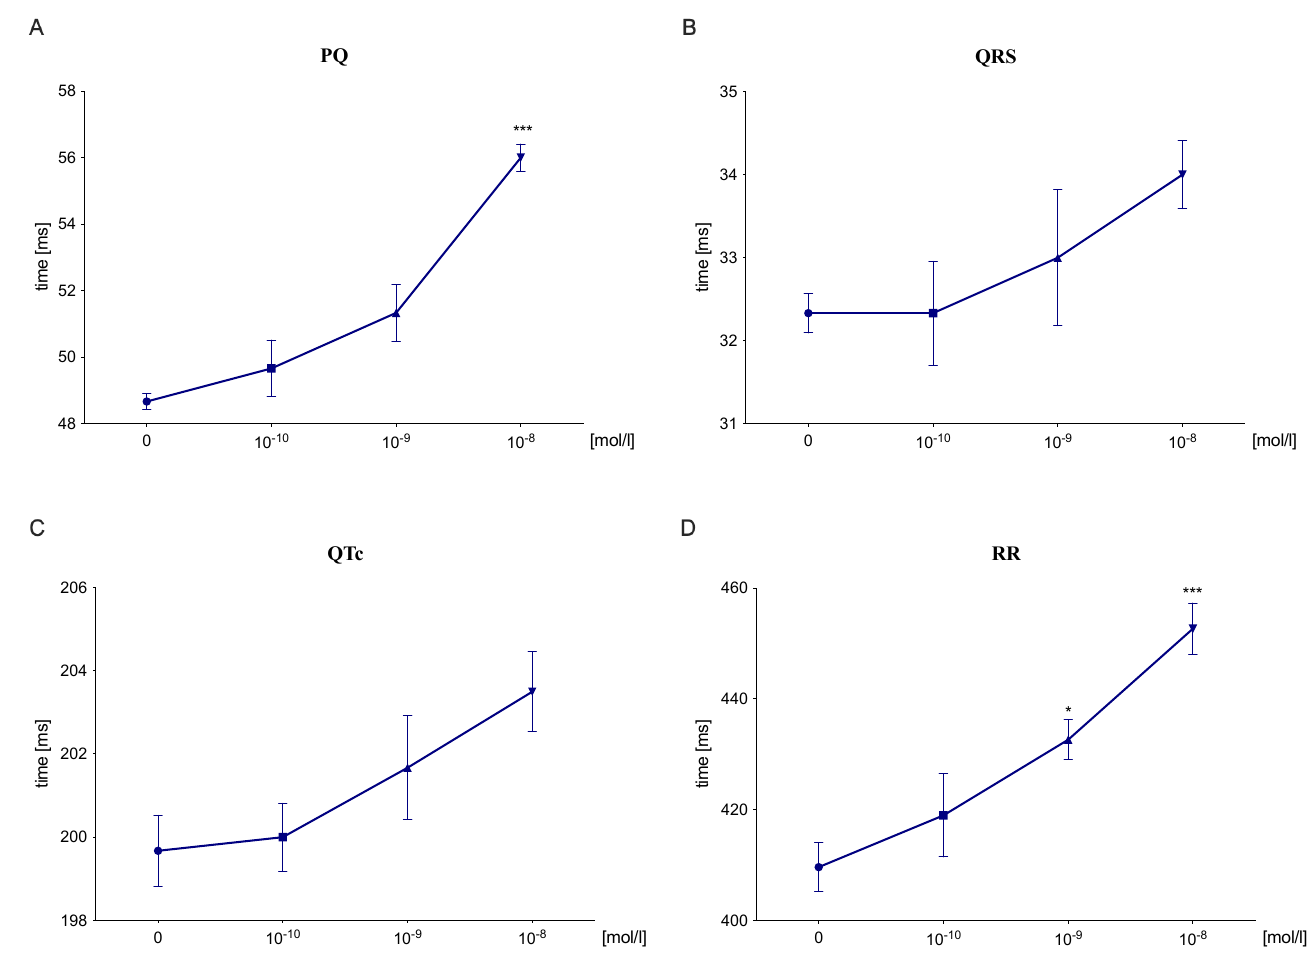
Figure 1. The effect of S-75 on the ECG components of the isolated rat heart. After stabilization period, the tested compound was administered directly to the nutrient fluid, in which heart was submerged, every 15 min at increasing concentrations of 10 −10 –10 −8 mol/L. The influence on PQ ( A ), QRS complex ( B ), QTc ( C ), and RR interval ( D ) was assessed. The results are presented as mean ± SEM. Statistical analysis: Shapiro–Wilk test for data normality, and one-way repeated measures ANOVA (Dunnett’s post hoc); * p < 0.05, *** p < 0.001; n = 4 hearts. Table 3. The effect of the tested compound on chosen parameters in arrythmia models in rats. Treatment Dose